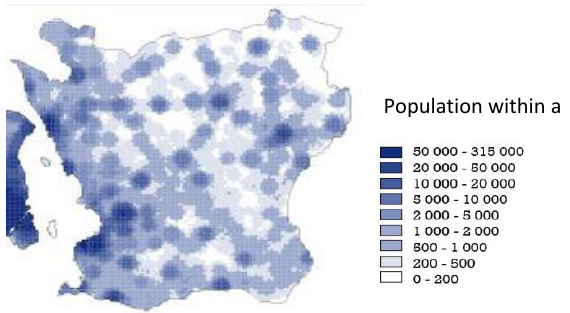
Figure 2. Map of Southern Sweden (county Scania) showing population density across the region. © Lantmäteriet (License No.